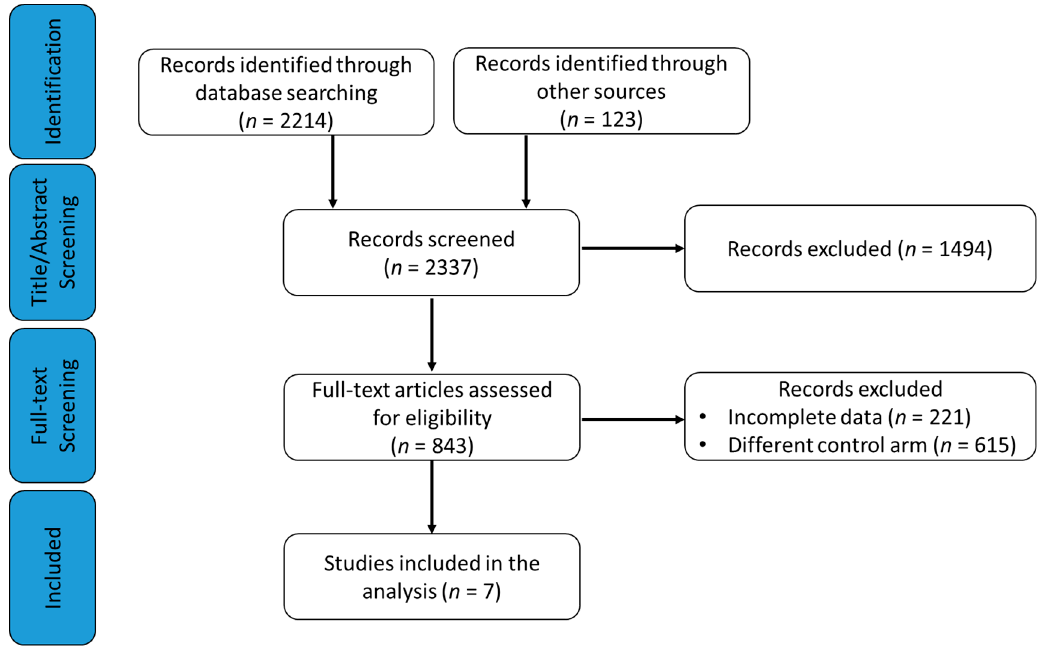
Figure 1. The Preferred Reporting Items for Systematic Reviews and Meta-Analyses (PRISMA) flow chart summarizing the process for the identification of the eligible